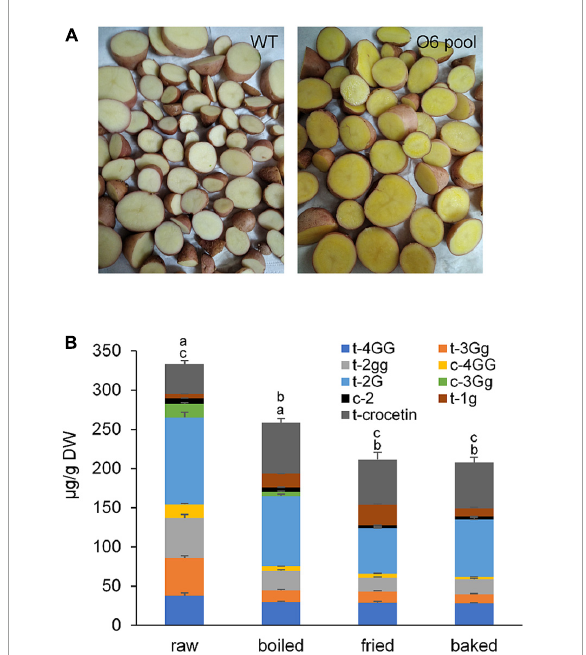
FIGURE6 Potatoes (cv. Desirée) used for cooked stability of crocins and bioaccessibility experiments. (A) Internal phenotype of wild type (WT) (cv. Desirée) potato tubers and O6 transgenic (cv. Desirée) potato tuber pool. (B) Crocetin and crocetin ester contents in raw and cooked potato tubers accumulating the characteristic apocarotenoids in saffron. Different letters represent statistically significant differences of means, of cooking procedures, according to factorial analysis of variance (ANOVA) ( P ≤ 0.05) (Tukey test). Above letters in correspond to differences in total crocins content, and letters below correspond to differences in crocetin